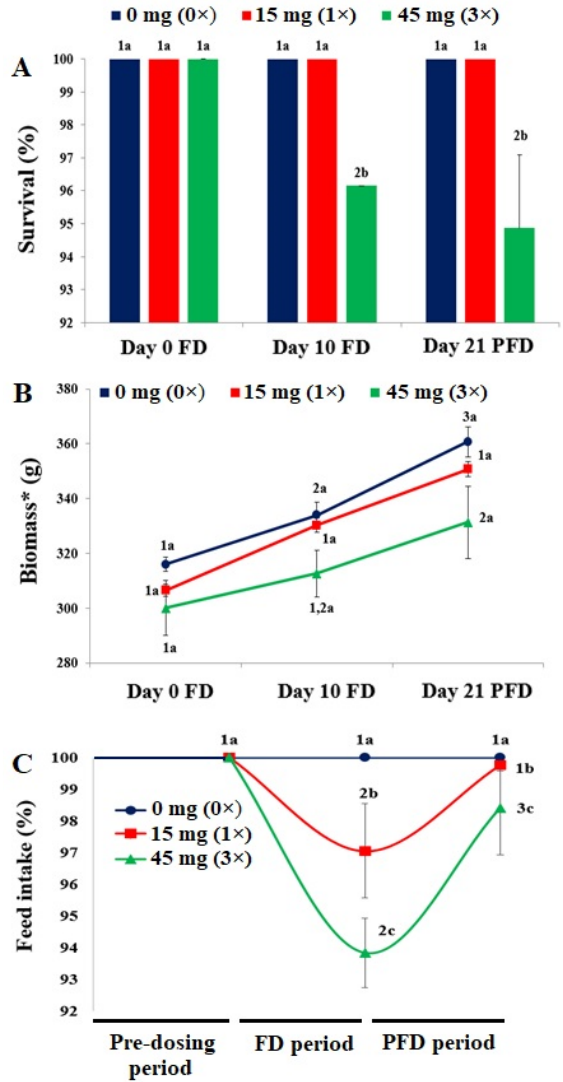
Figure 1. Effects of florfenicol (FFC) dosing at 0–3 times the therapeutic dose of 15 mg kg biomass − 1 day − 1 for 10 consecutive days on ( A ) survival, ( B ) biomass, and ( C ) feed intake of Oreochromis niloticus juveniles during the experimental period. Pre-dosing period: 0–7 days; FFC-dosing (FD) peri- 8–17 days; post-FFC-dosing (PFD) period: 17–38 days. * Biomasses of 10 fish from each of the triplicate tanks. a–c: bars and line markers sharing a common alphabet for a particular day or dosing period differed insignificantly ( p > 0.05). 1–3: bars and line markers sharing a common numeral for